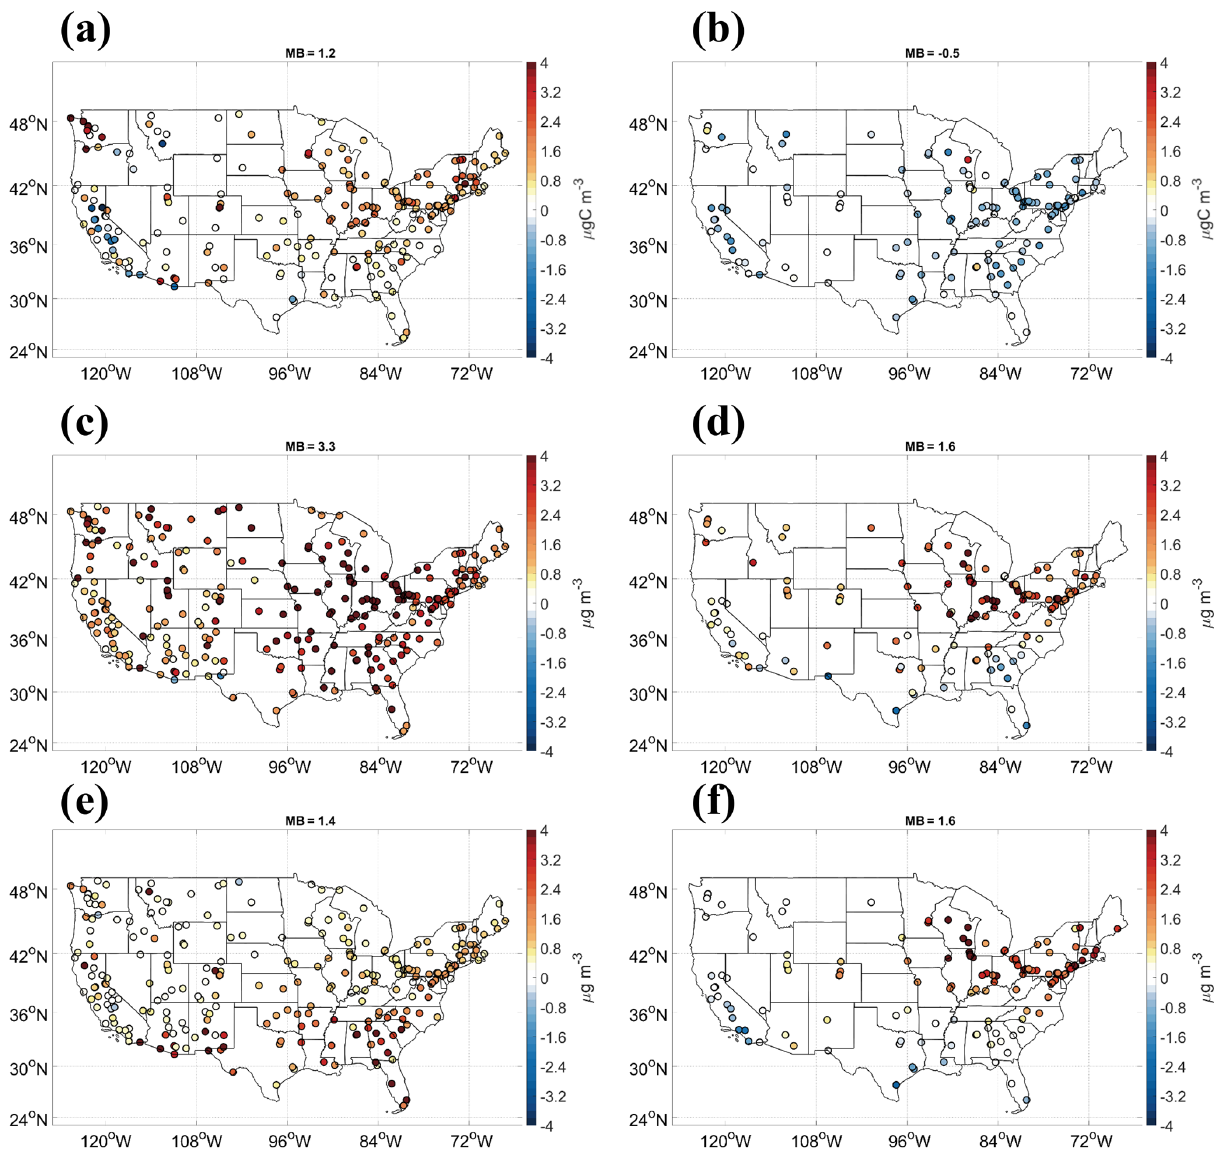
Figure 9. Mean biases in PM 2 . 5 compositions: (a) OC for January, (b) OC for July, (c) SOIL for January, (d) SOIL for July, (e) sulfate for January, and (f) sulfate for